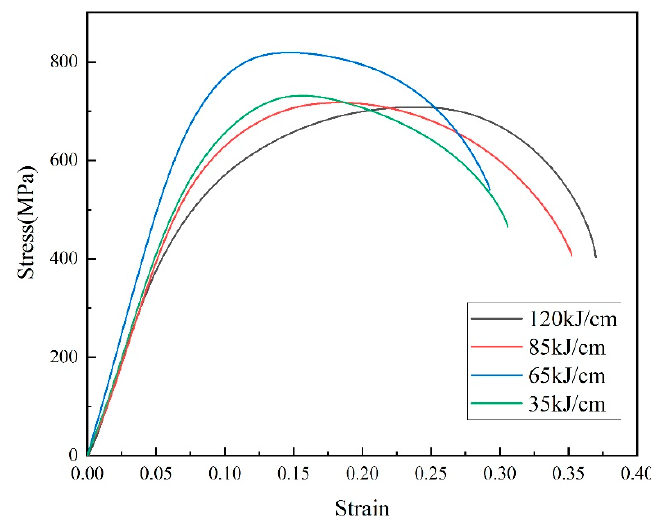
Figure 3. Stress-strain curves.